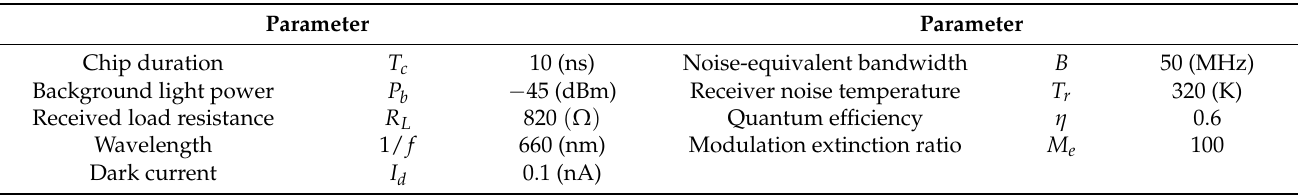
Table 6. Nominal parameters in system model.